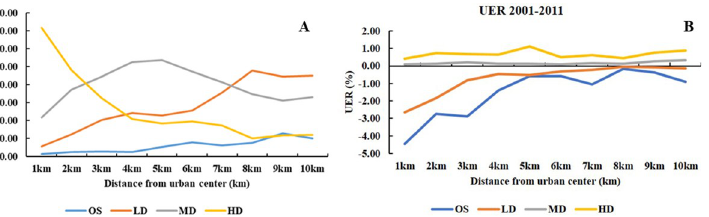
Fig 6. Urban density classes and Urban Expansion Rate (UER) variation at varying distances from the urban center of Milwaukee County. (A) Urban density classes variation within 1–10 km buffers. (B) Urban Expansion Rate (UER) variation within 1–10 km buffers.